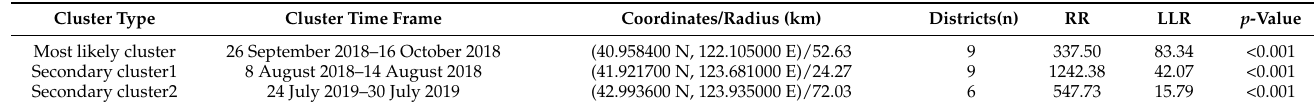
Table 3. Results of the spatiotemporal cluster test on ASF cases at the district or county level in